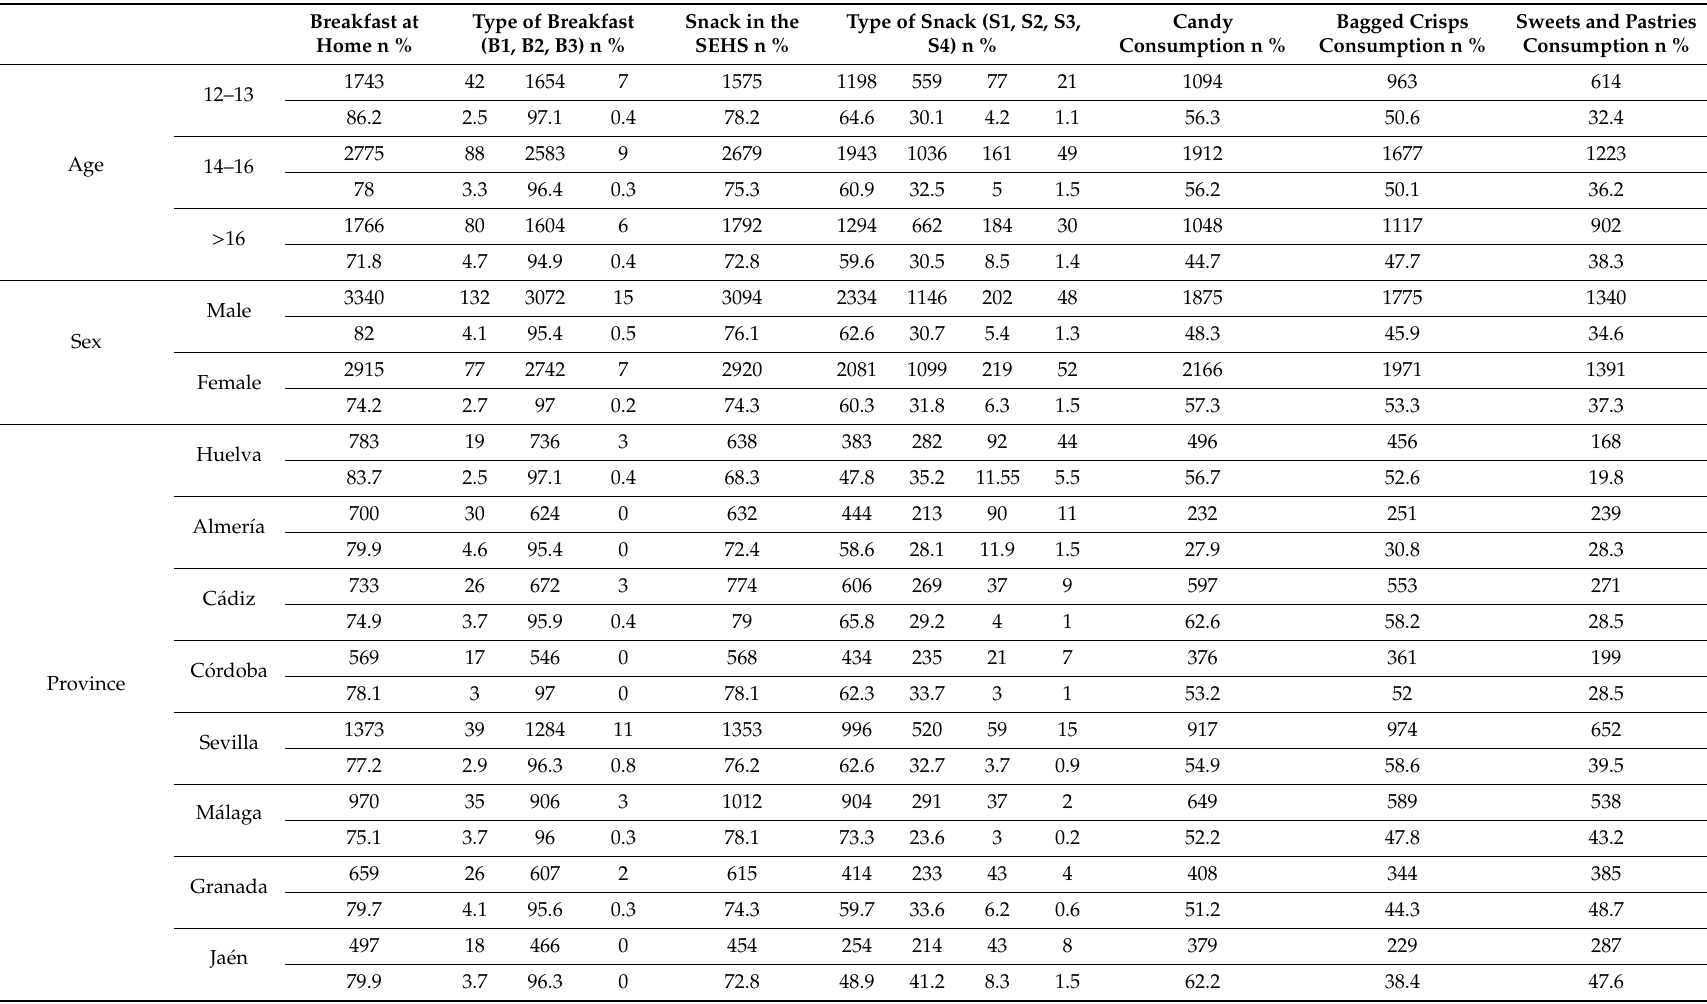
Table 3. Eating habits according to sociodemographic characteristics, the existence of a cafeteria and physical